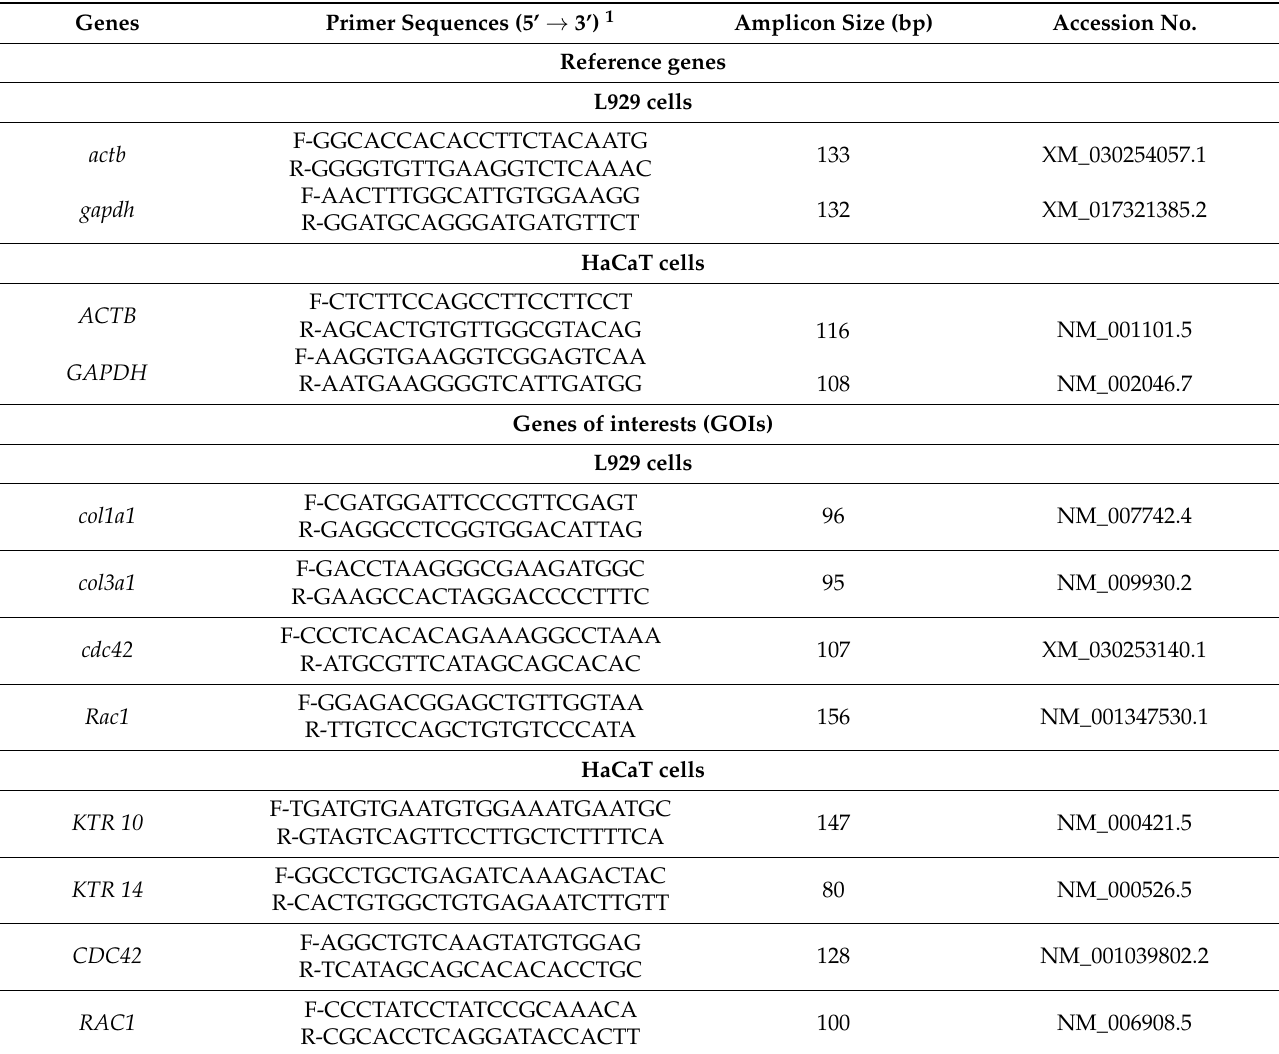
Table 3. Set of primer sequences used for real-time PCR